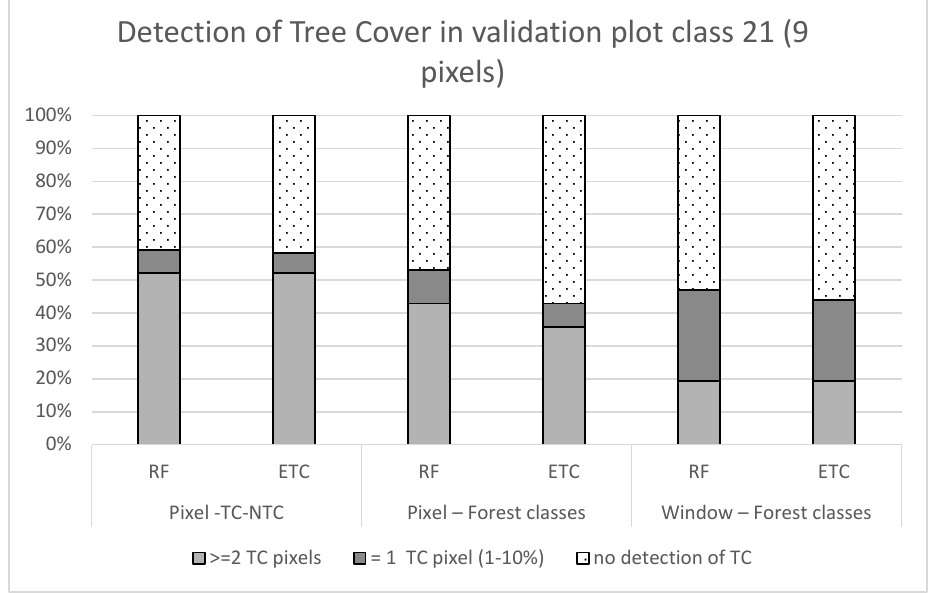
Figure 13. Assessment of the class 1–10% tree cover for the 98 validation plots with a class 21.